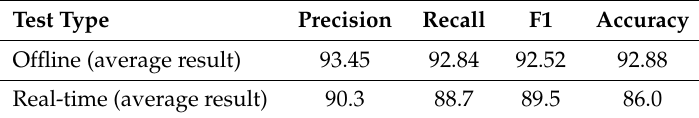
Table 4. Performance measures-SSD